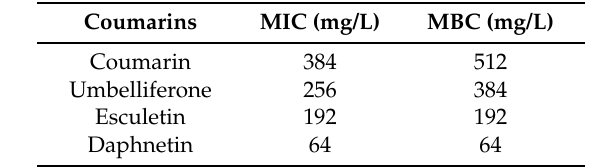
Table 2. The minimum inhibitory concentrations (MICs) and minimum bactericidal concentrations (MBCs) of hydroxycoumarins against R. solanacearum in the 96-well polystyrene microtiter plates. Coumarins MIC (mg/L) MBC (mg/L) Coumarin 384 512 Umbelliferone 256 384 Esculetin 192 192 Daphnetin 64 64 Each experiment was repeated in three